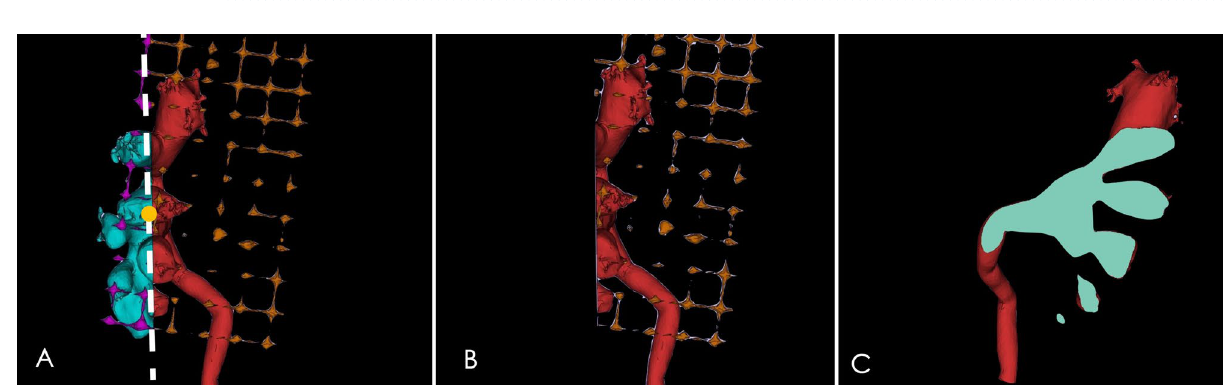
Figure 4. Simulated location of skin puncture points. ( A – C ) From different points of view, the axis of the targeted renal calyx (blue, rod-like) extended to the body surface. The point that intersected with the grid surface patch was the point of skin puncture. The figure was edited with Magics 20.03 (https:// www. mater ialise. com).